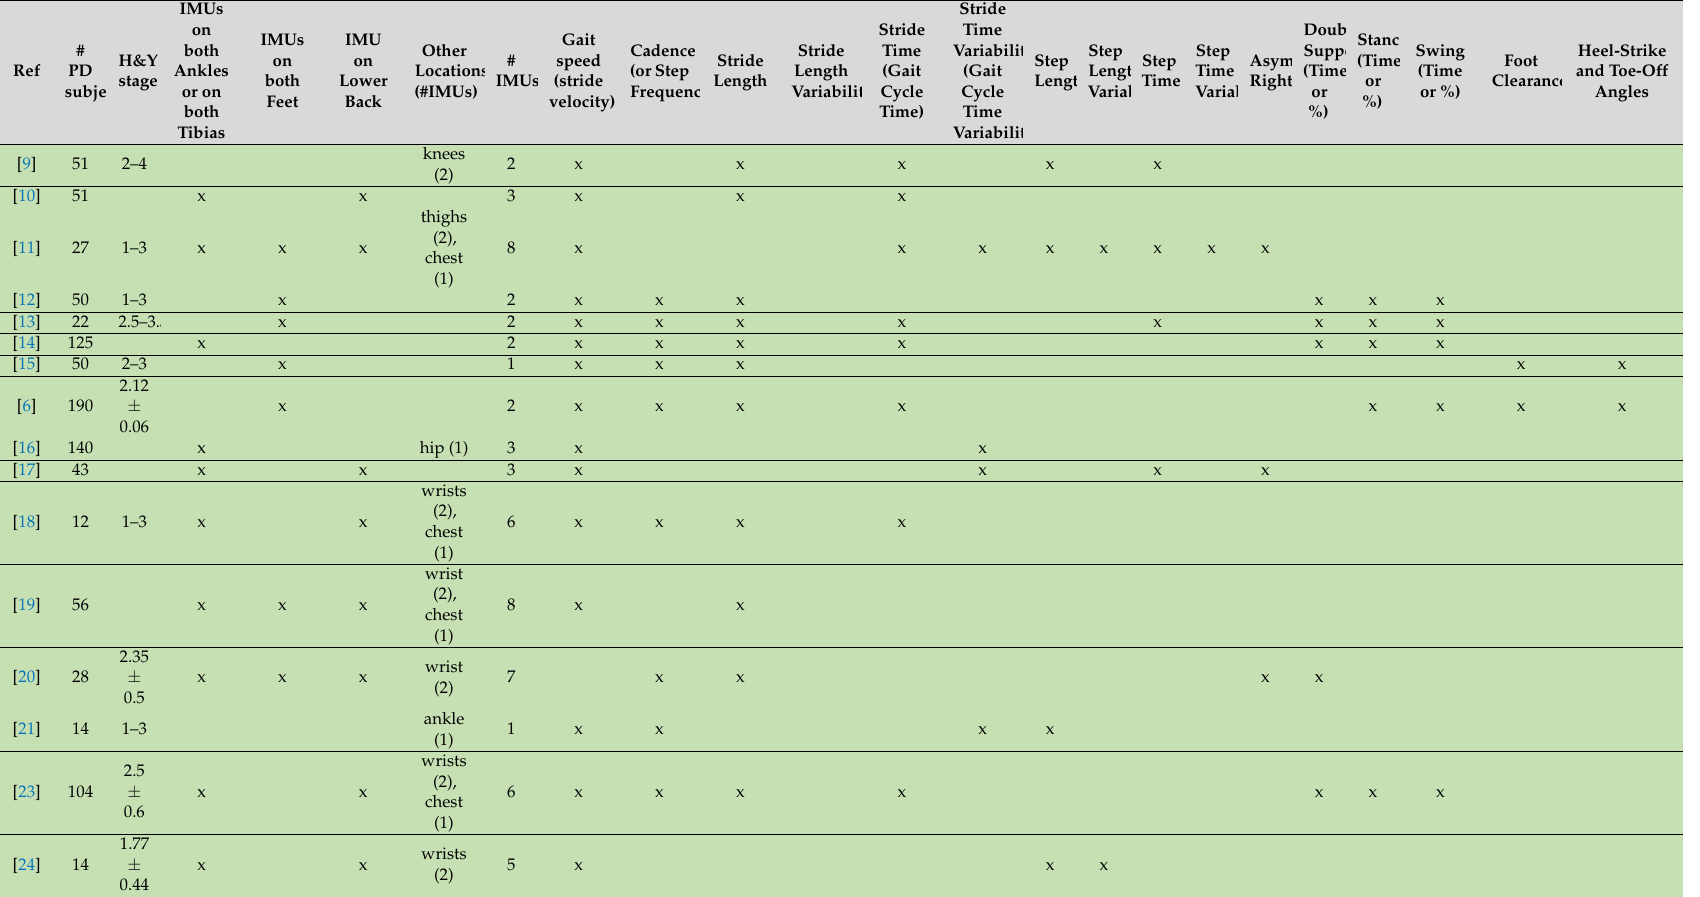
Table 1. Characteristics of wearable sensors and parameters. H&Y: Hoehn and